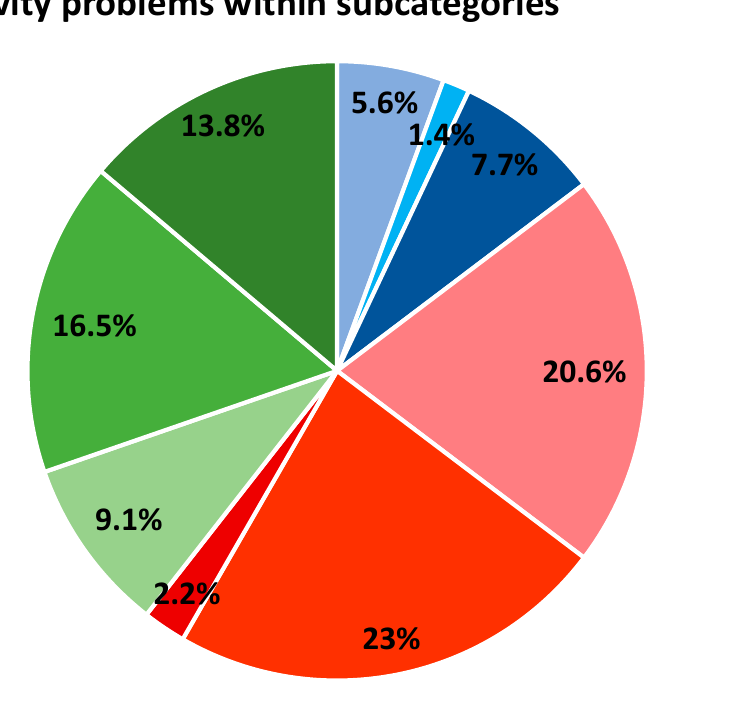
Figure 7. Distribution of prioritised activity problems (%) within the COPM subcategories: self-care (blue) comprising personal care, functional mobility and community management; productive ac- tivities (red) comprising paid/unpaid work, household management and play/school; leisure activ- ities (green) comprising quiet recreation, active recreation and socialisation. Patients were the op- portunity to prioritise up to five activity problems (see Section 2). COPM data is based on 415 pa- tients.